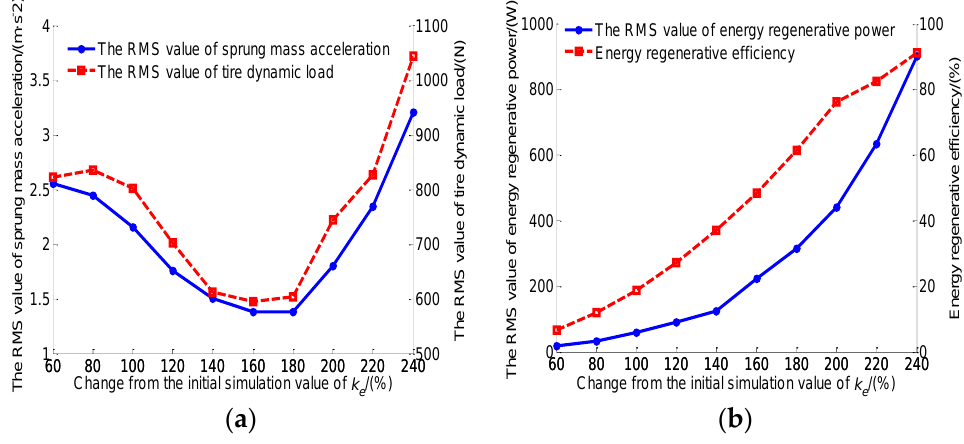
Figure 8. Influence of the back electromotive force constant of the generator on evaluation indicators: ( a ) Influence of the back electromotive force constant of the generator on the damping performance; ( b ) Influence of the back electromotive force constant of the generator on energy regenerative performance.